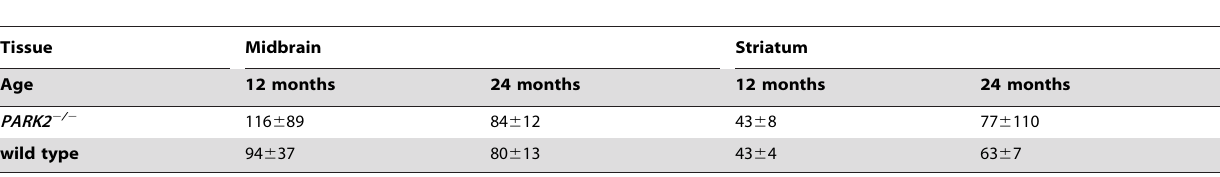
Table 2. Proteasome activities were similar in PARK2 2 / 2 and wild type